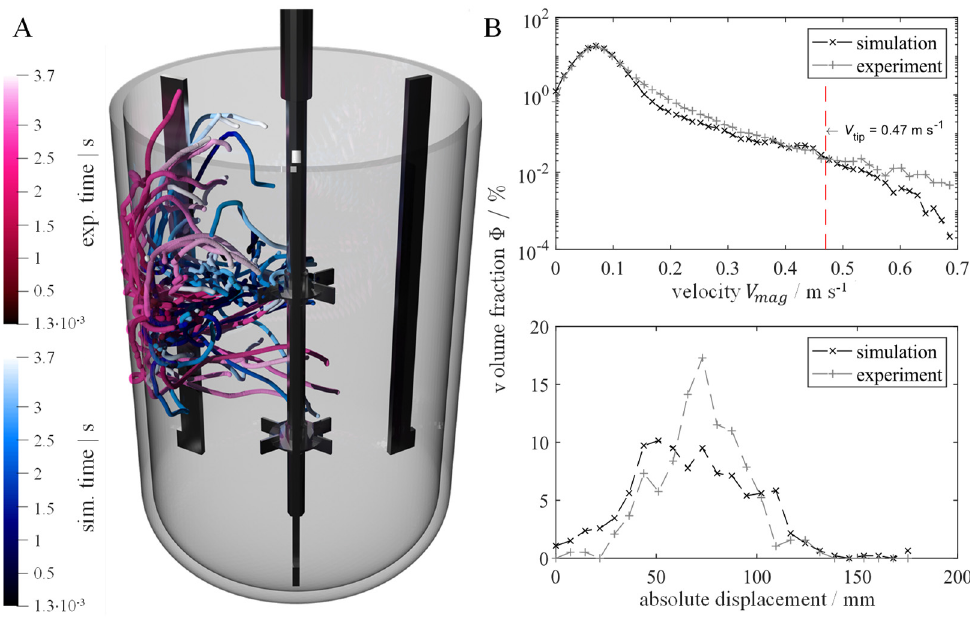
Figure 8. Visualization of experimental (magenta) and simulated particle trajectories for the baffled system at 𝑛 = 250 rpm ( A ). Velocity distribution (upper) and absolute displacement of filtered particle trajectories ( B ).